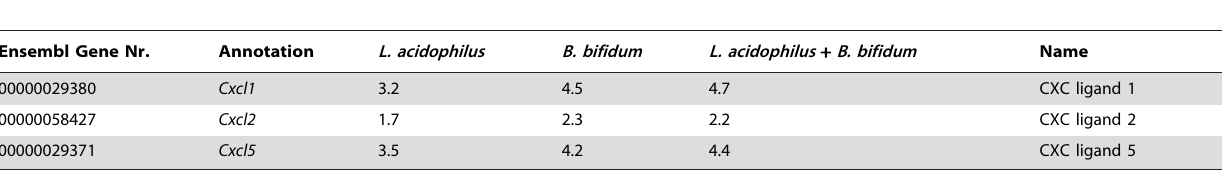
Table 3. Additive Effects of Bifidobacterium bifidum Z9 on the Chemokine Expression in Lactobacillus acidophilus NCFM stimulated Dendritic Cells.